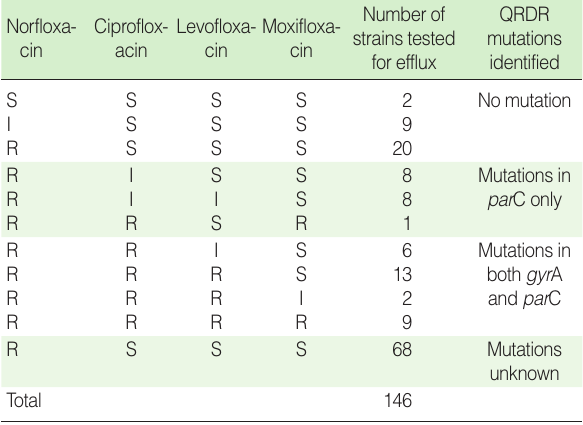
Table 1. Fluoroquinolone resistance of selected group B Strepto- coccus screened for the efflux phenotype. The 146 isolates were selected from 1,075 clinical and colonizing clinical group B Strep- tococcus isolates from South Korea (2006-2008)